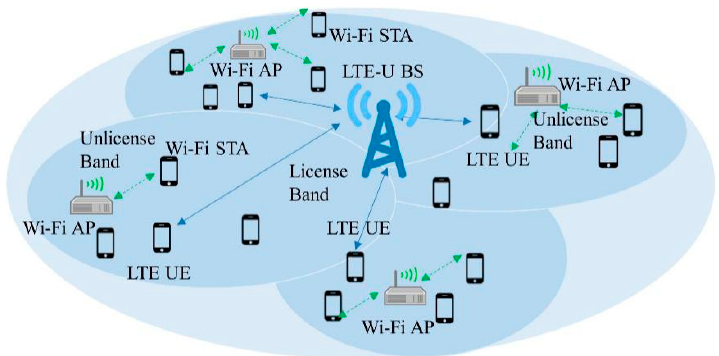
Figure 3. LTE-U deployment scenario.